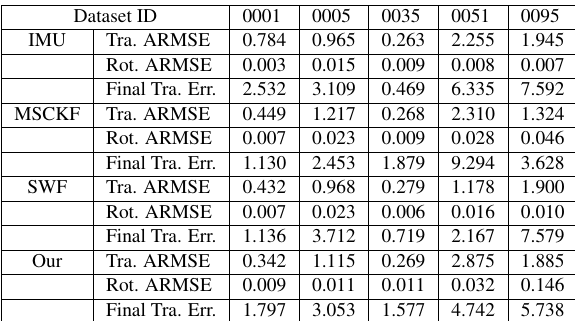
Table 1: Comparison of translation ARMSE, rotation ARMSE, and final translation error of proposed method, MSCKF, and SWF on KITTI dataset. (units: m )